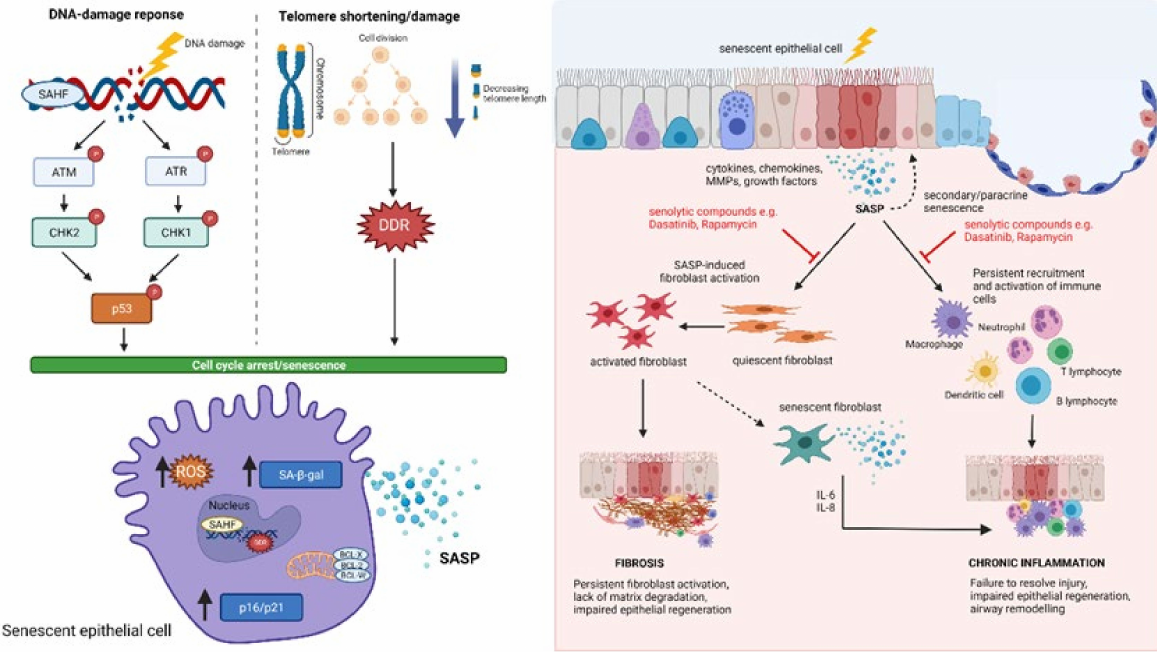
Figure 5. Schematic diagram of epithelial senescence in the lung. Cellular senescence can be triggered in response to different stimuli, including telomere shortening/damage and engagement of the DNA-damage response (DDR). Senescent cells upregulate expression of senescence-associated heterochromatin foci (SAHF), senescence-associated β -galactosidase activity (SA- β -gal), p16 and p21 and secrete a multitude of chemokines, cytokines, proteases, and growth factors known as the senescent-associated secretory phenotype (SASP). Senescent epithelial cells exert diverse roles in the lung due to the heterogeneity of SASP factors, including activation of fibroblasts and immune cells to drive fibrosis and inflammation, respectively. Senescent epithelial cells can also induce senescence in neighbouring cells, reinforcing growth arrest, impairing epithelial regeneration and efficient lung function. Senescent fibroblasts further impair lung function and repair of epithelial cells, suggesting bi-directionality and positive feedback mechanisms driving epithelial damage and fibroblast activation. Senolytic compounds including Dasatinib and Rapamycin can successfully attenuate fibroblast activation and immune cell recruitment in the lung, making modulation of senescence an attractive therapeutic target for several chronic diseases. Created using